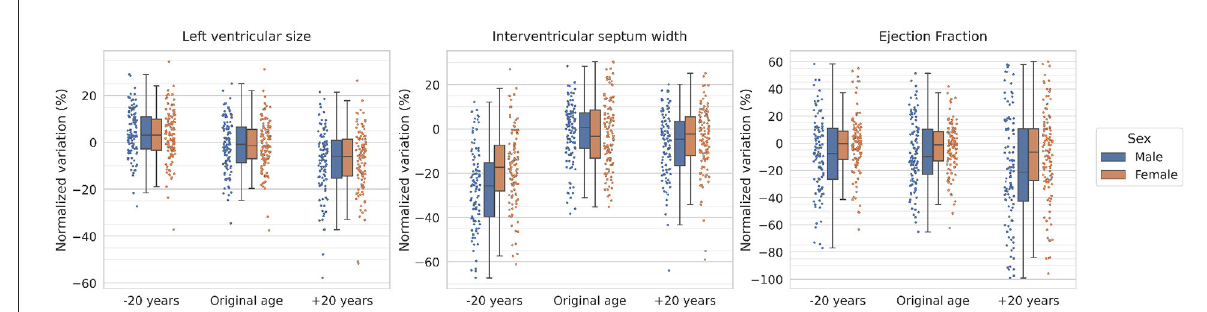
FIGURE4 Normalized volumetric variations of synthesized images for the left ventricle, the interventricular septum and the ejection fraction. Every dot represents a subject and the boxes represent the interquartile range. The normalized variation is computed as the normalized difference of the selected metric with respect to the mean value for the original distribution (i.e., the “Original age” distribution). The results are obtained for a subset of participants aged 60.